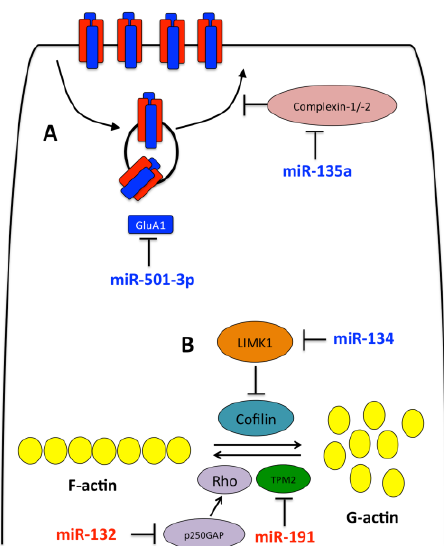
Figure 2. miRNAs involved in aclivity dependent AMPAR trafficking and dendritic structural plasticity. ( A ) miRNAs involved in NMDA-mediated AMAPR expression and trafficking. In response to NMDA, miR-501-3p is upregulated resulting in GluAl suppression and miR-135a is downregulated causing an increase in complexin-1/-2 levels and resulting in reduced AMAPR exocytosis; ( B ) miRNAs involved in dendritic structural plasticity miR-134 actrvity is enhanced in response to NMDA, resulting in downregulation of LIMK1 and activation of the actin depolymerizer, cofilin. Furthermore, expression of miR-132 and miR-191 increase, resulting in suppression of Rho signaling and Tropomodulin-2 (TPM2) respectively, thus repressing actin polymerization.